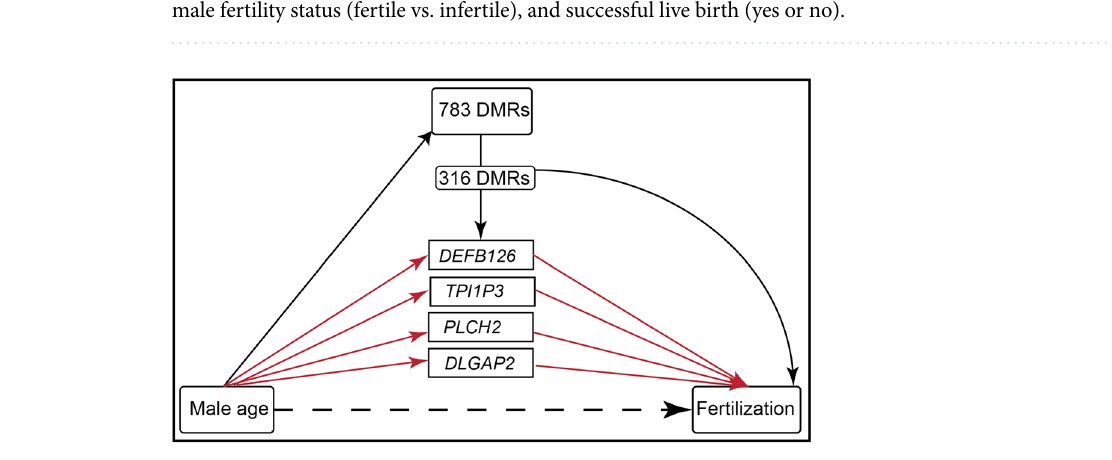
Figure 7. Schematic representation of mediation analyses for fertilization. The estimated association is provided on each pathway: the association between male age and each mediator; the association between each mediator and the outcome, and finally the remaining association of male age on the outcome, which is not mediated the DMRs (i.e. the direct effect). Total effects (TE) of age on outcomes is considered to be the sum of natural direct effect (dashed arrow) and natural indirect effect (red